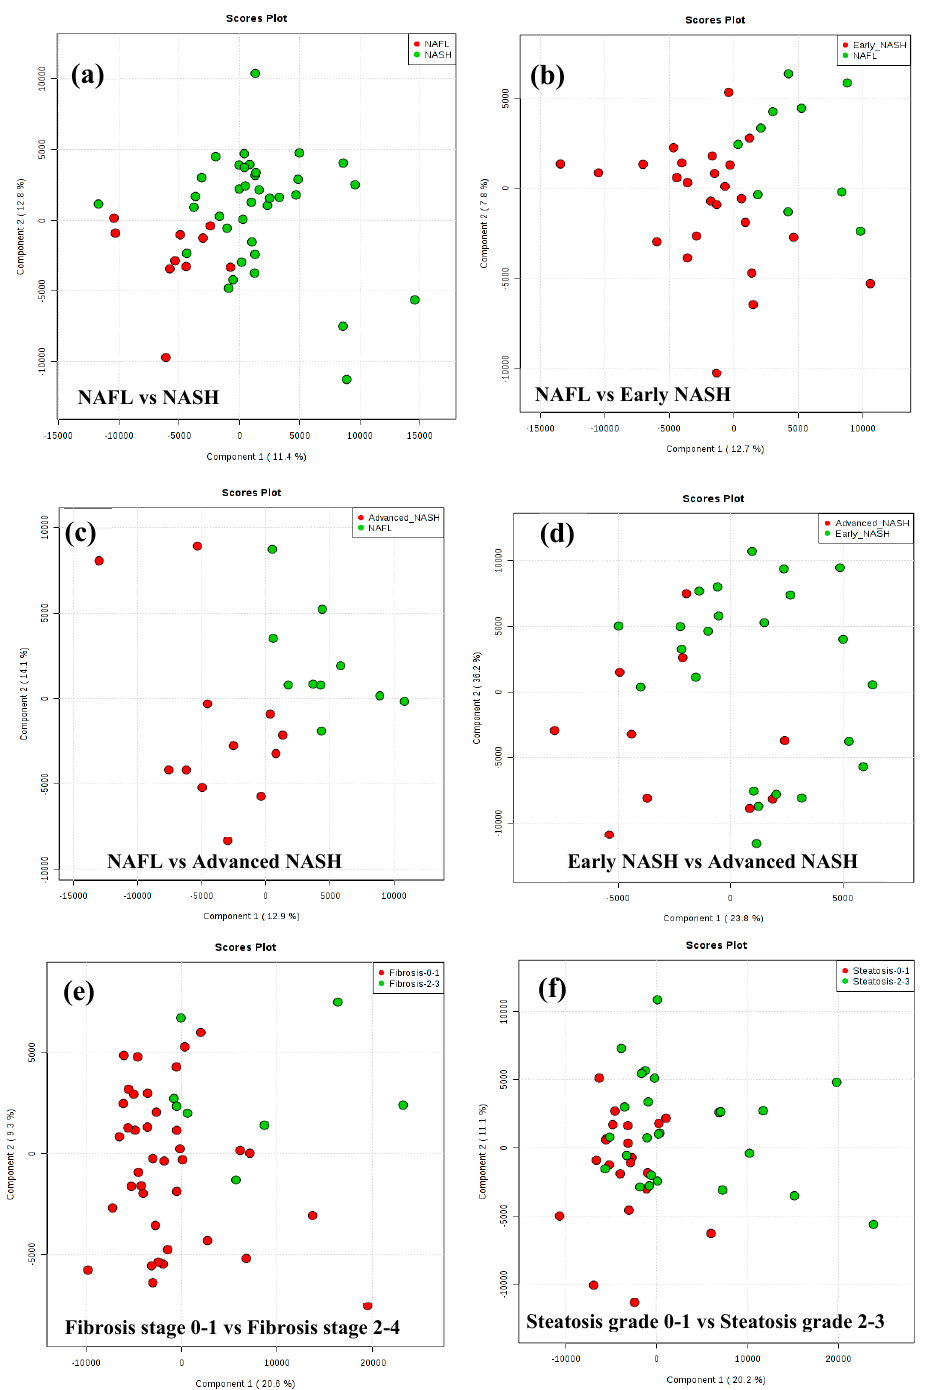
Figure 1. The results of PLS-DA analysis of metabolite levels derived from MS are shown as score plots. Each red or green point in the score plot represents one patient. In these plots, points (known as scores) for patients that exhibit similar metabolite profiles will appear closer to each other and vice versa. The score plots show good clustering and separation of the patients with ( a ) nonalcoholic fatty liver (NAFL) vs. NASH; ( b ) NAFL vs. early NASH; ( c ) NAFL vs. advanced NASH; ( d ) Early NASH vs. advanced NASH; ( e ) Fibrosis stage 0–1 vs. Fibrosis stage 2–4; and ( f ) Steatosis grade 0–1 vs. Steatosis grade 2–3.